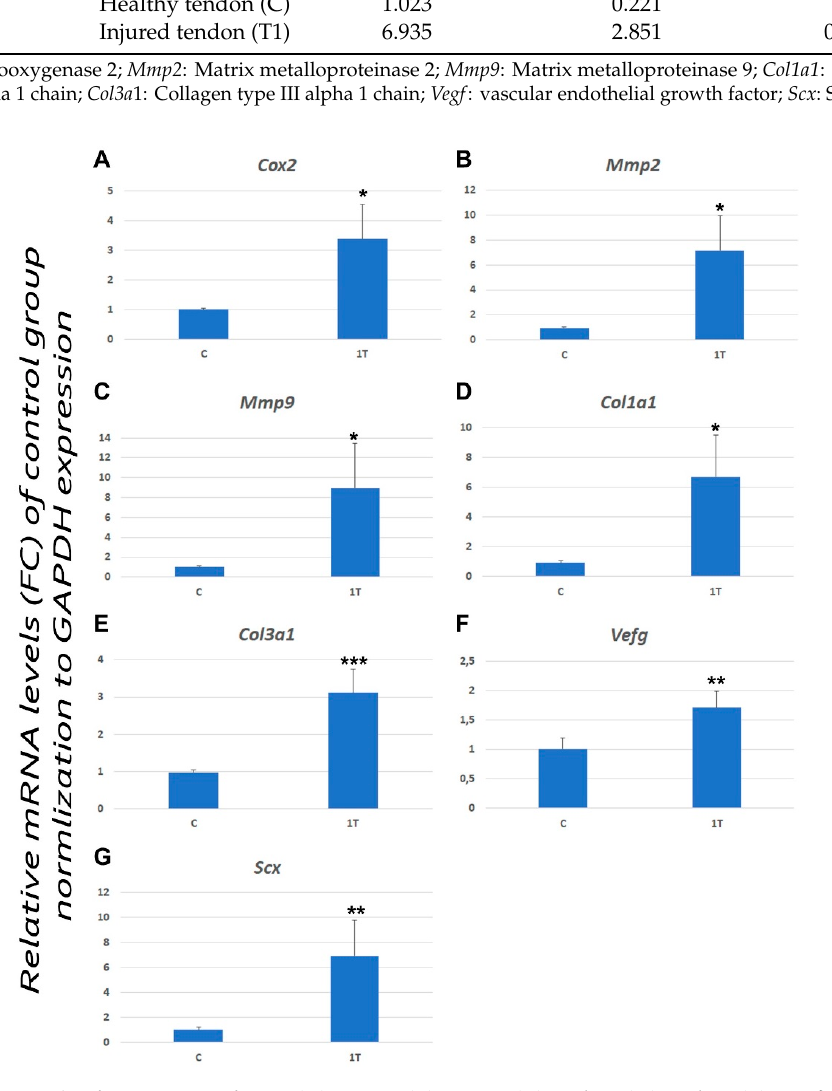
Figure 5. Levels of expression of Cox2 ( A ), Mmp2 ( B ), Mmp9 ( C ), Col1a1 ( D ), Col3a1 ( E ), Vegf ( F )